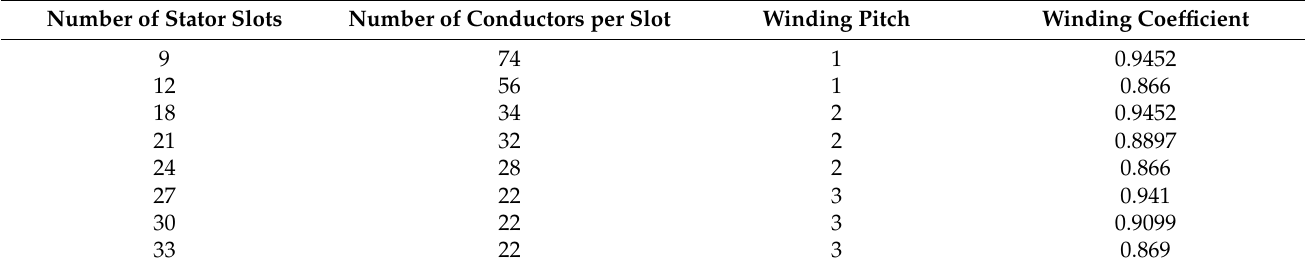
Table 3. Machine design schemes when the number of rotor poles is 8 and the number of stator slots takes different values. Number of Stator Slots Number of Conductors per Slot Winding Pitch Winding